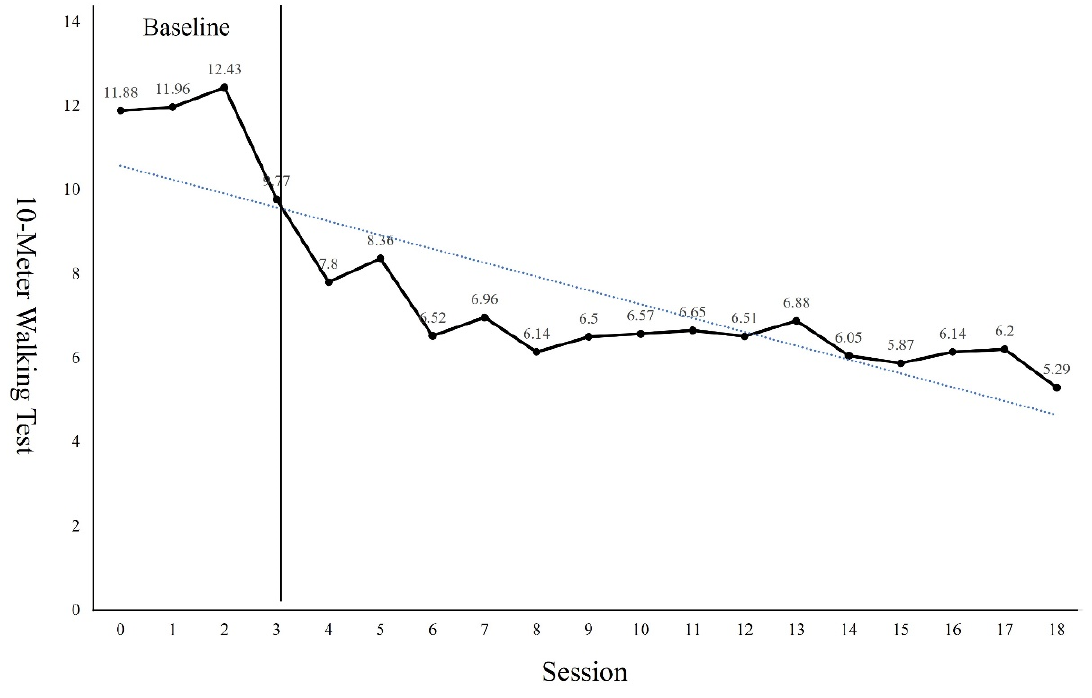
Figure 6. Changes of 10MWT.